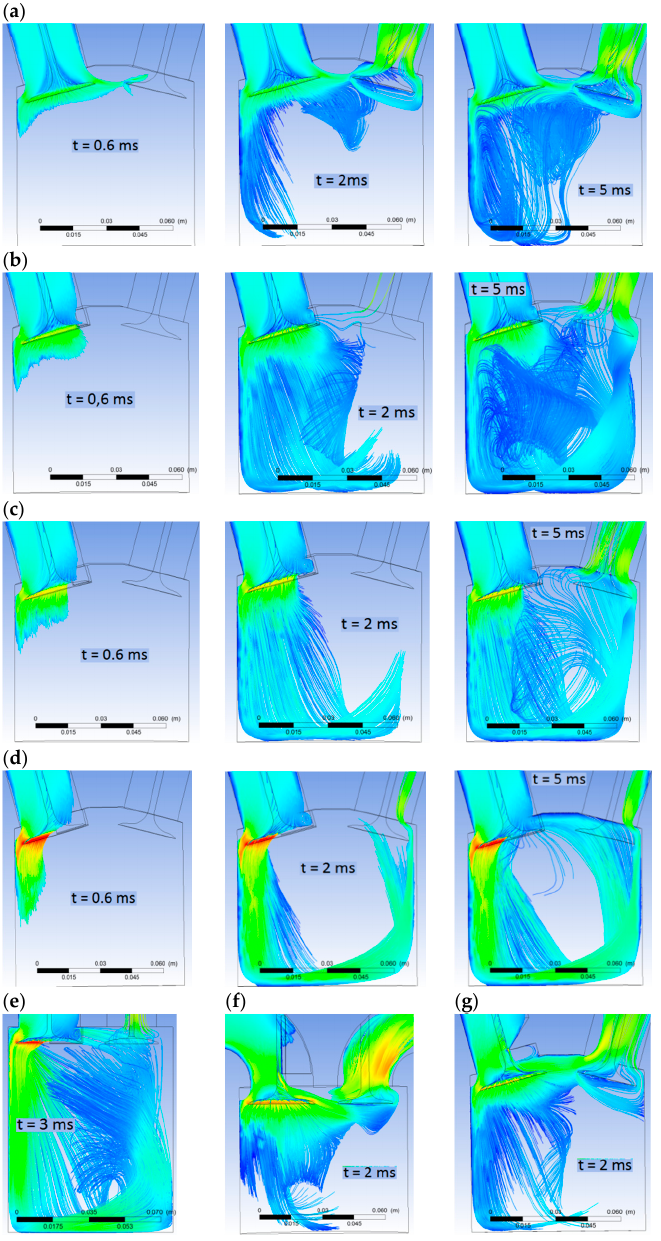
Figure 5. Flow simulations for a schematic 2-valve 500 cm 3 cylinder with propagating fresh air, forced to 100 m / s through the intake; images are color coded for velocity (dark blue: 50 m / s, green: 175 m / s, yellow: 250 m / s). ( a ) Unchanged inlet provides poor scavenging with premature and high losses. ( b ) Obstruction angle α = 90 ◦ : Loop scavenging with less premature loss. ( c ) More distinct tumbling for α = 120 ◦ . ( d ) Pregnant tumbling for α = 180 ◦ . ( e ) Jockey for a schematic diesel cylinder with prolonged bore and flat head. ( f , g ) Fixed directors in the inlet do not perform in these